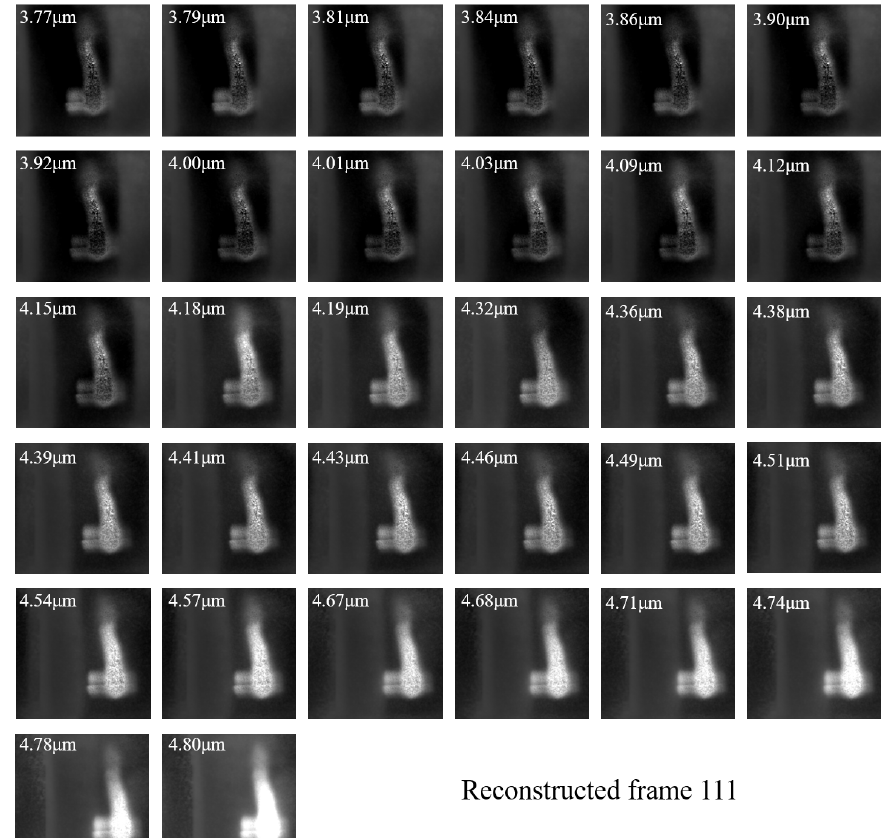
Figure 17. Reconstructed spectral images by our reconstruction